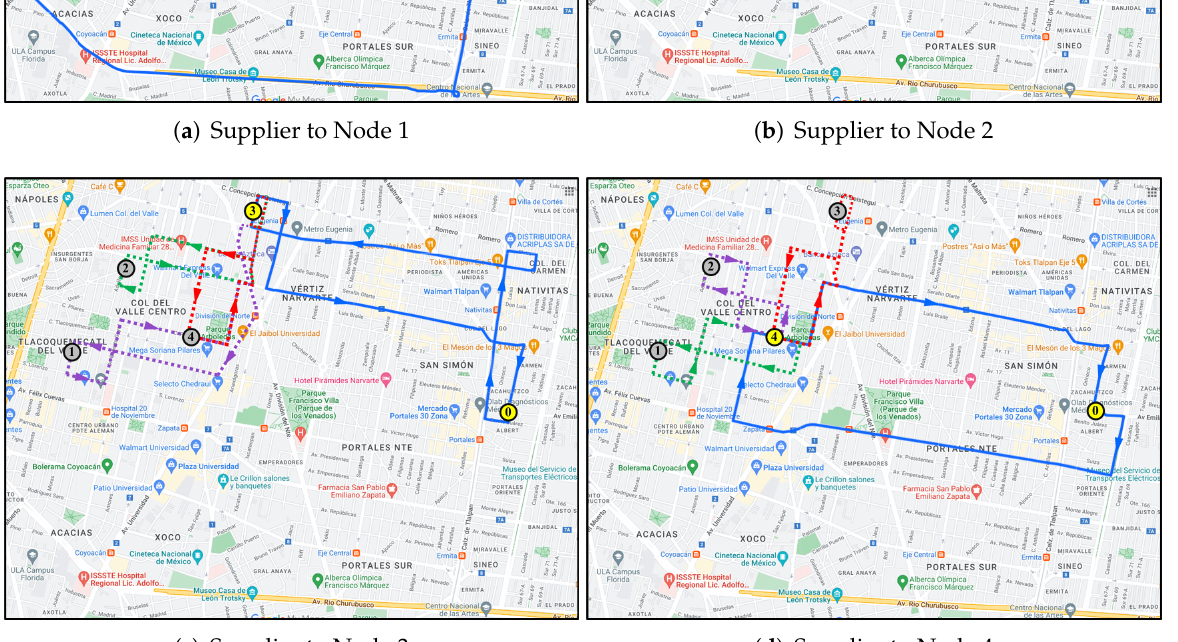
Figure 9. Map validation for supplier and customers travelling. Figure 9. Validation of deliveries